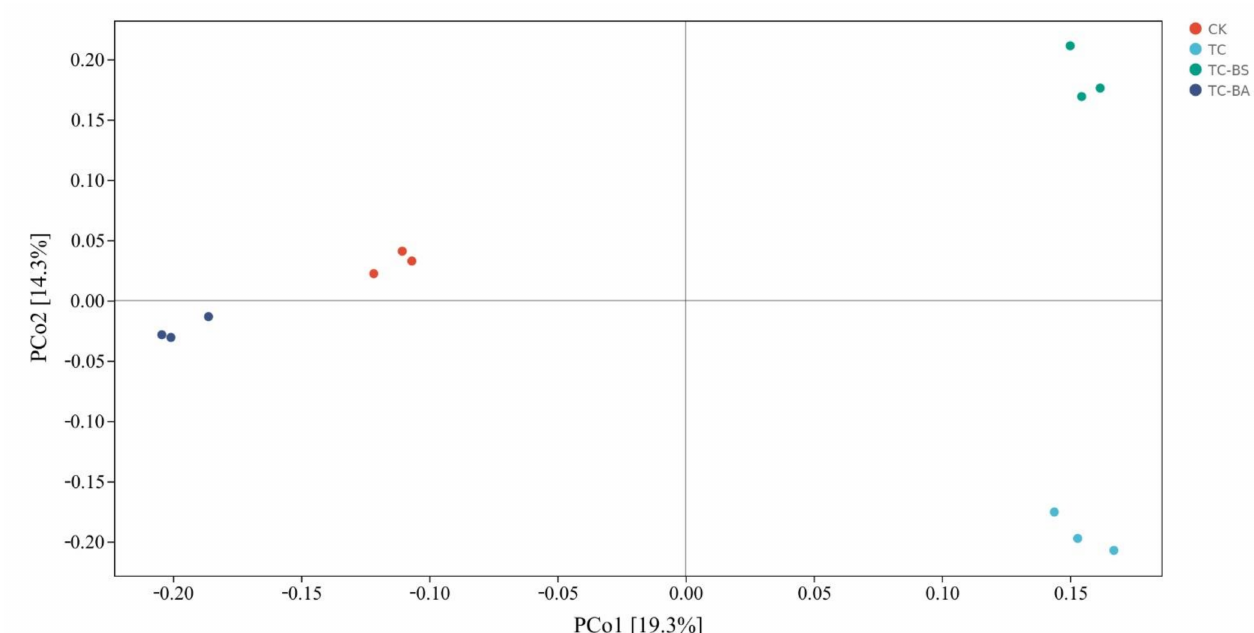
Figure 4. Principal coordinate analysis (PCoA) of the ginger field soil bacterial